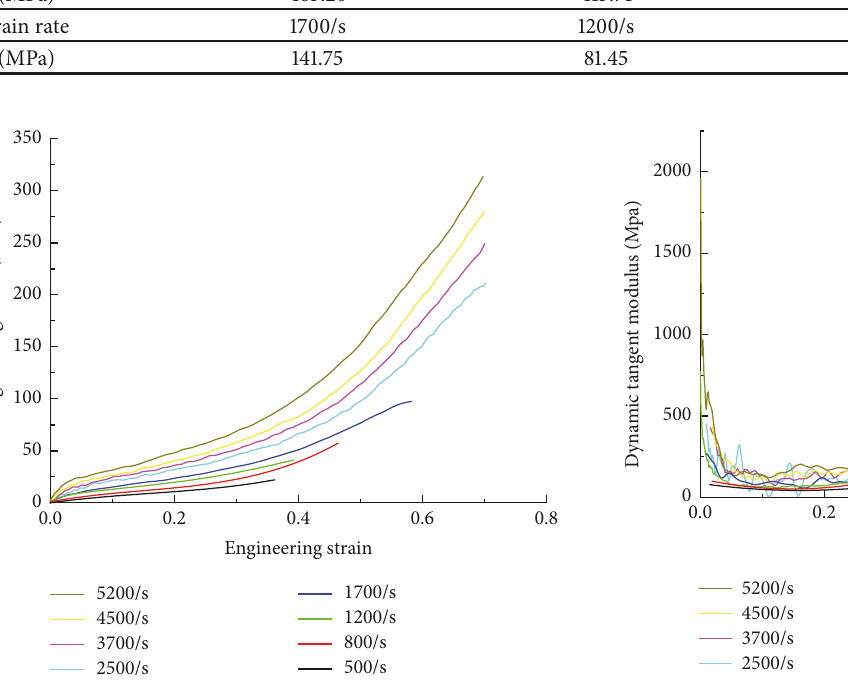
Figure 8: Dynamic modulus curve of high-damping